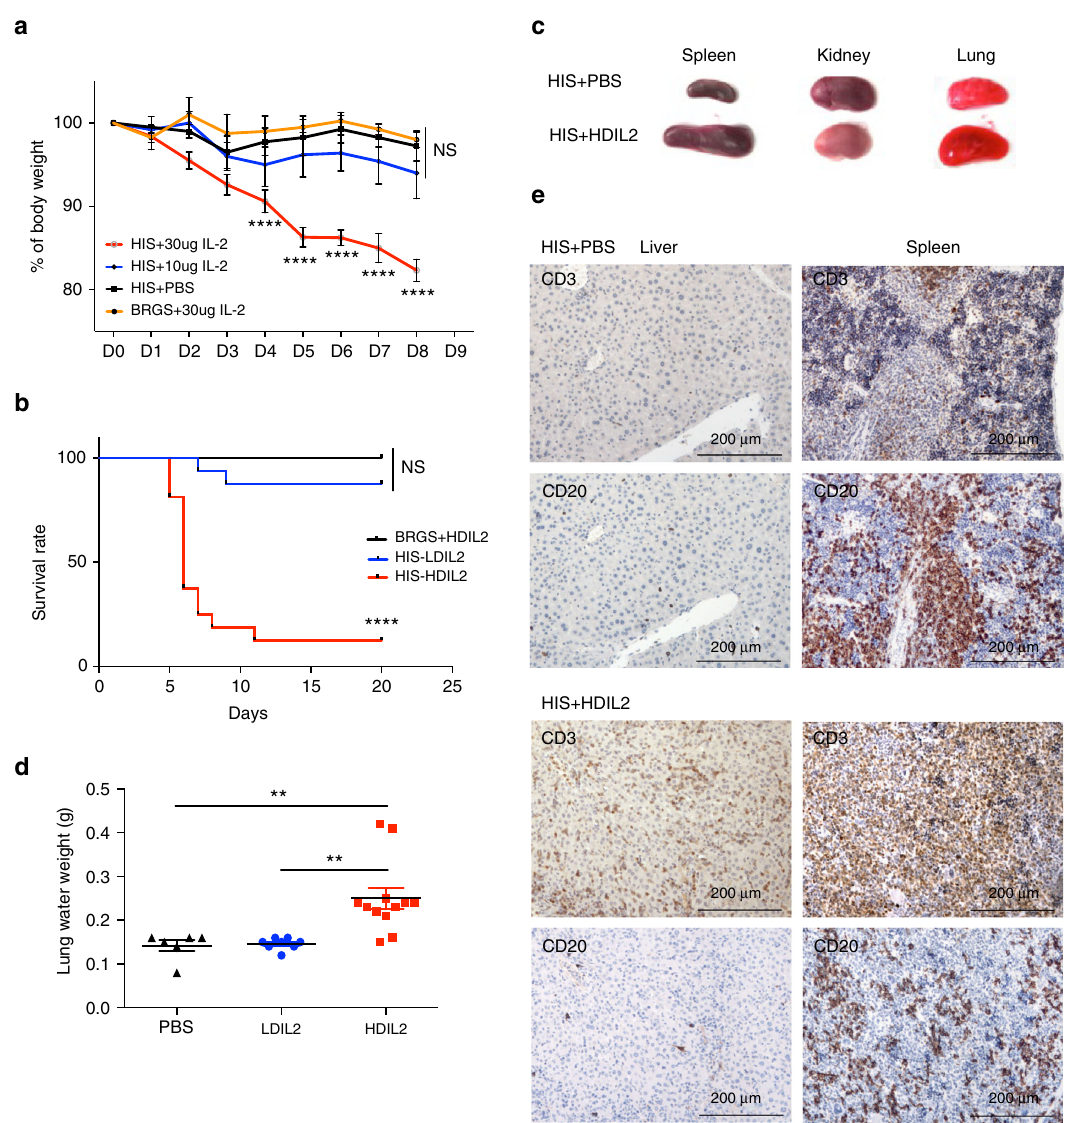
Fig. 1 IL-2 induces dose-dependent toxicity in human immune system mice. 10 – 14-week-old BALB/c Rag2 − / − Il2rg − / − Sirpa NOD (BRGS) mice and reconstituted human immune system (HIS) mice were hydrodynamically injected with PBS only, 10 μ g and 30 μ g human IL-2 encoding plasmids. a Percentages of body weight change after hydrodynamic injection in HIS mice ( n = 5 per group). The data are representative of two independent experiments. Comparisons are between PBS-injected HIS mice and the other groups by repeated-measures two-way ANOVA with a Sidak test. b Kaplan − Meier survival curves of HIS mice and BRGS mice injected with IL-2 encoding plasmids ( n = 10 for BRGS + HDIL2 group, n = 16 for other groups), Log-rank test. c Representative images of post-mortem examination of spleen, kidney, and lung from HIS mice treated with PBS or high-dose IL-2 (HDIL2). d Pulmonary edema in HIS mice treated with PBS, low-dose IL-2 (LDIL2), or HDIL2 were measured by lung water weight. Lung water weight was calculated by subtracting weights of dried lungs from that of wet lungs. The data are pooled from two independent experiments, analyzed by 1-way ANOVA test with a Tukey test. e Representative immunohistochemistry staining of CD3 or CD20 on sections from liver and spleen of HIS mice treated with PBS or